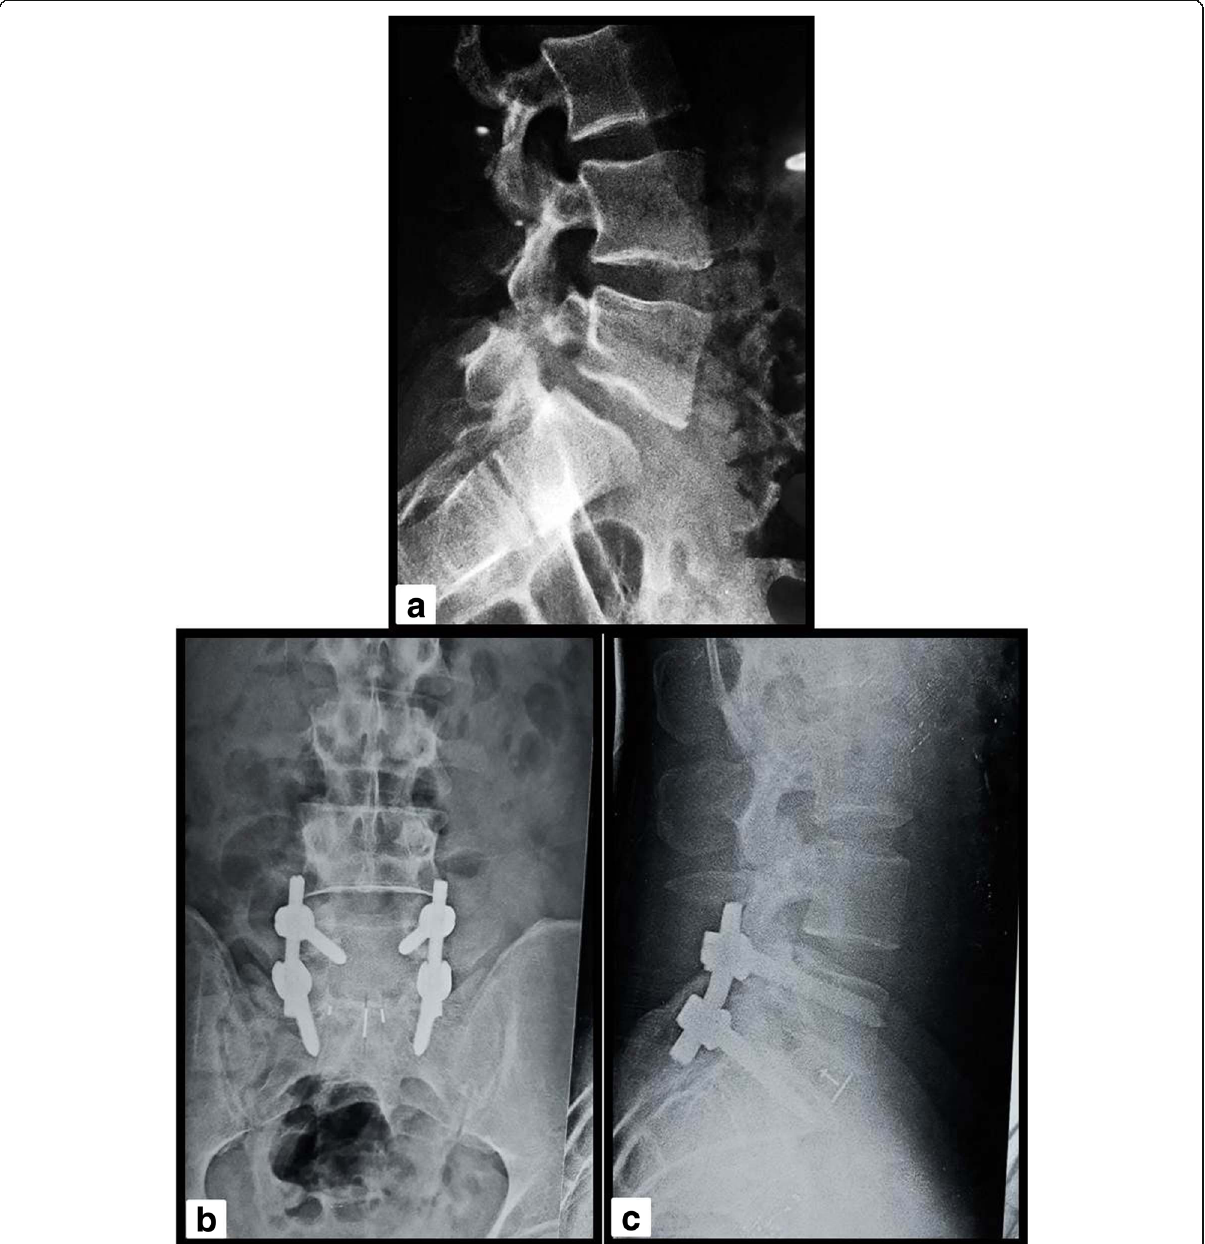
Fig. 2 TLIF procedure for the patient with isthmic L5 S1 spondylolisthesis. a Preoperative X-ray lateral view. b, c Posteroanterior and lateral X-ray films 6 months after surgery. Note the reduction in the anterolisthesis, restoration of disk height, and the visible bone